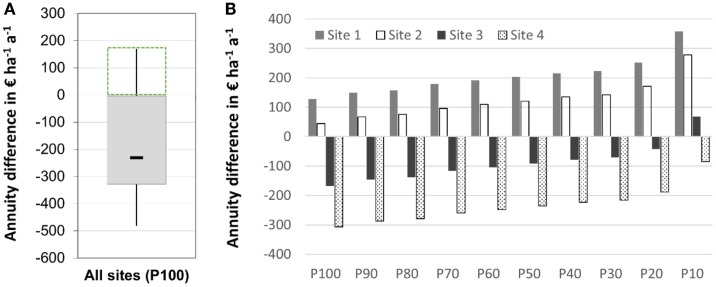
Minimum annuity difference (i.e., the annuity difference that was simulated with a 100% probability – P100) between poplar SRC and a reference crop rotation (wheat-oilseed rape-barley) for (A) all arable sites being subject to the reference crop rotation – dashed green box indicates the sites with a positive annuity difference as shown in more detail in Figure 7A, and (B) probability related annuity differences for exemplary sites to illustrate “probability profiles” of economic return (P10–P100 illustrate the percentiles of probability).